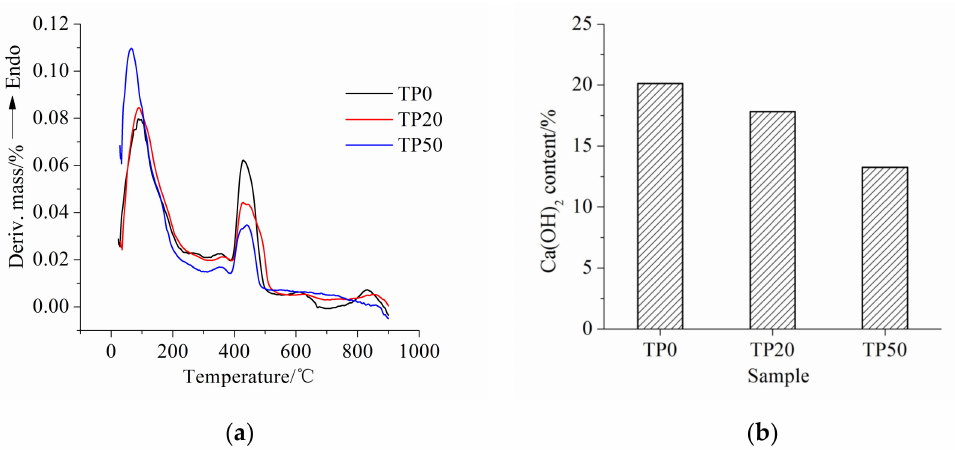
Figure 8. Thermogravimetric analysis of cement-ITP hardened paste cured for 365 days at 20 ◦ C: